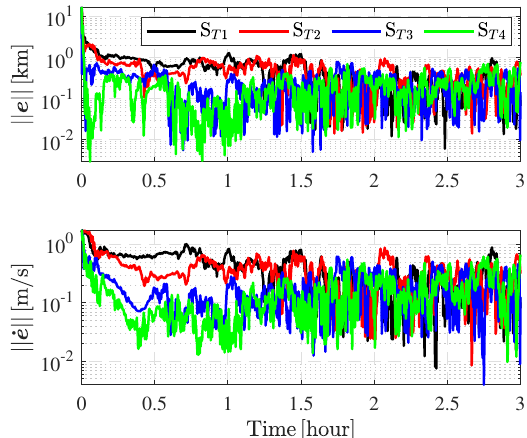
Figure 5. Time history of the estimated